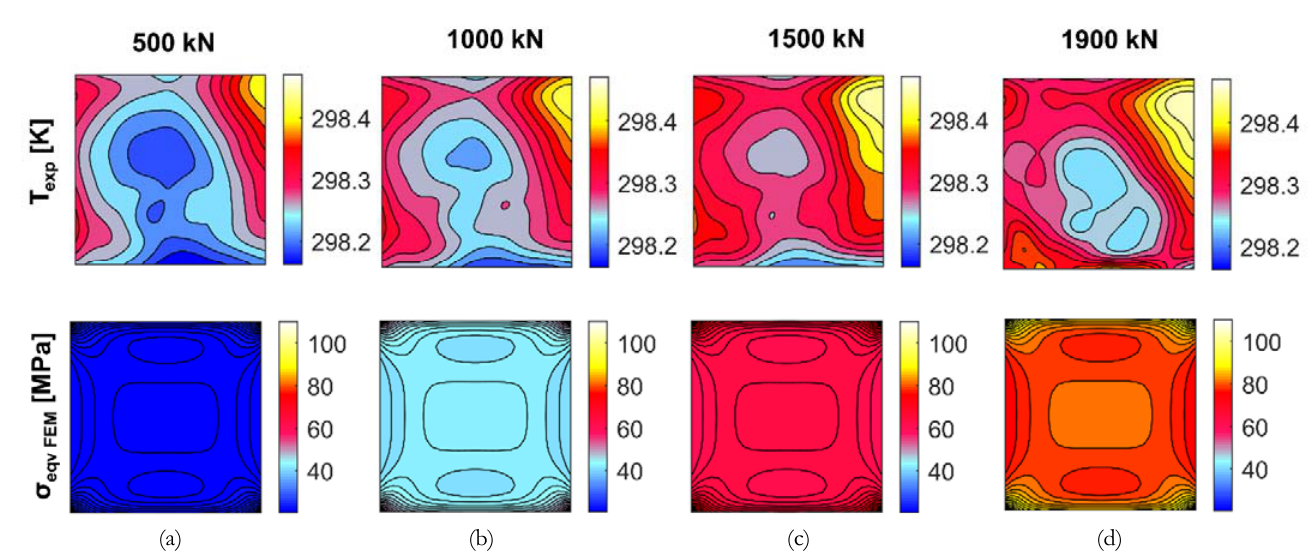
Figure 14: Comparison between a) experimental thermal and b) equivalent stress distribution on the